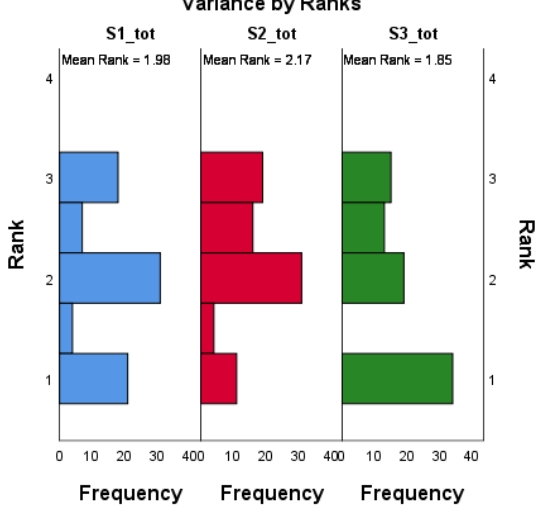
Figure 4. Related samples Friedman’s two-way ANOVA by ranks. Table 7. Related samples Friedman’s two-way ANOVA by ranks, summary.